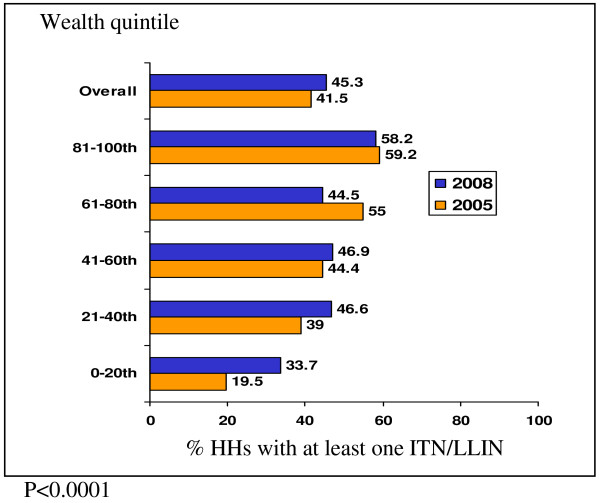
ITN ownership by wealth index in HH surveys.